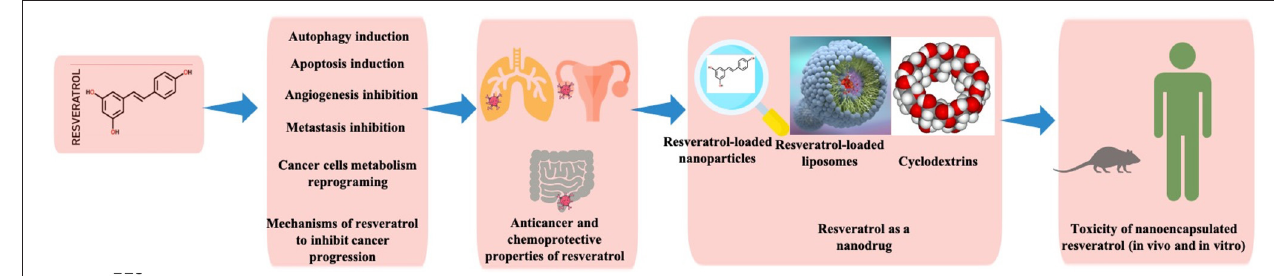
FIGURE 1 | Illustration showing various components discussed in the current